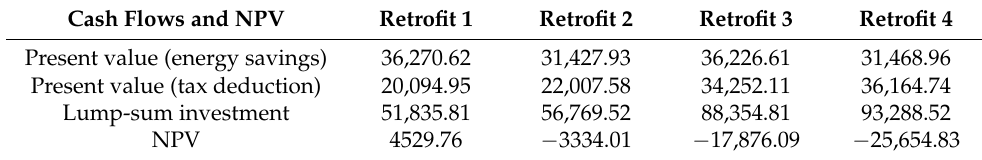
Table 3. Calculation of the net present value (NPV) of retrofit interventions (euros). Cash Flows and